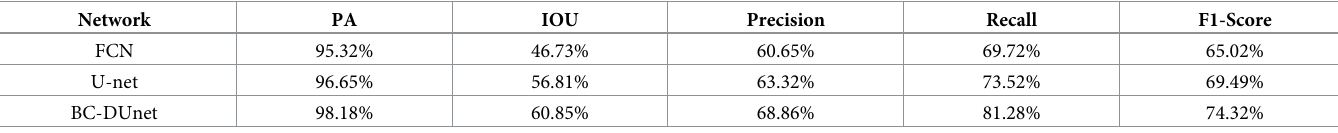
Table 2. Experimental performance comparison table.